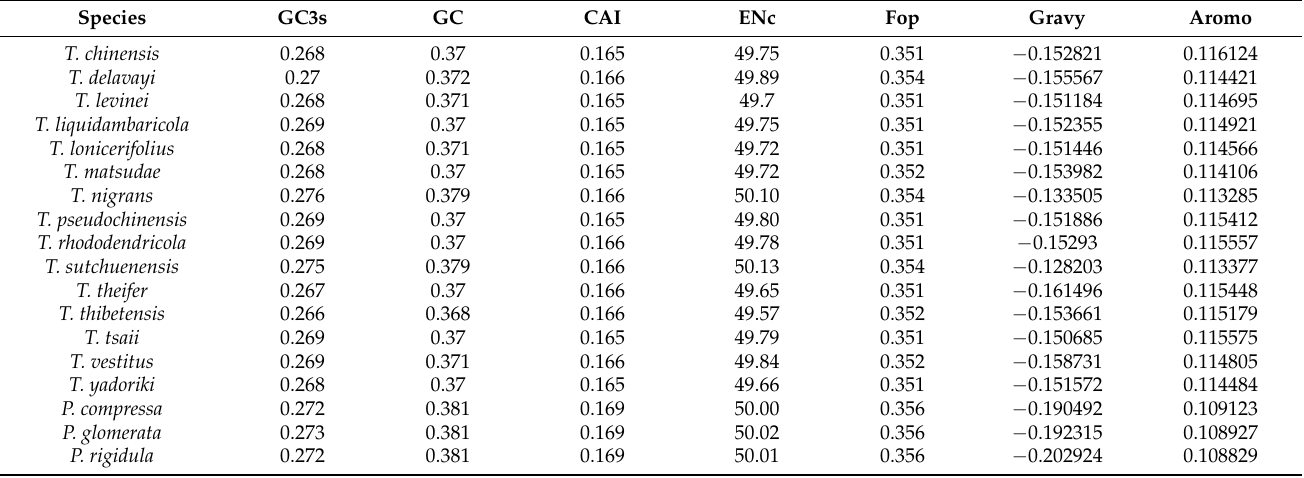
Table 1. Codon usage of Taxillus and Phacellaria